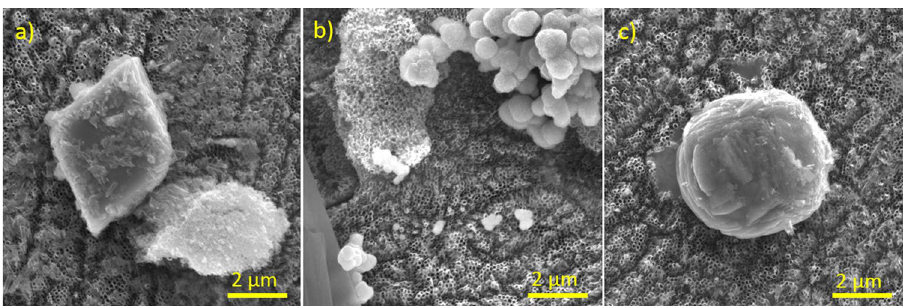
Figure 2. SEM images of samples: ( a ) TiO 2 /SrMoO 4 /GO, ( b ) TiO 2 /CoMoO 4 /GO, ( c ) TiO 2 /SrMoO 4 /CoMoO 4 /